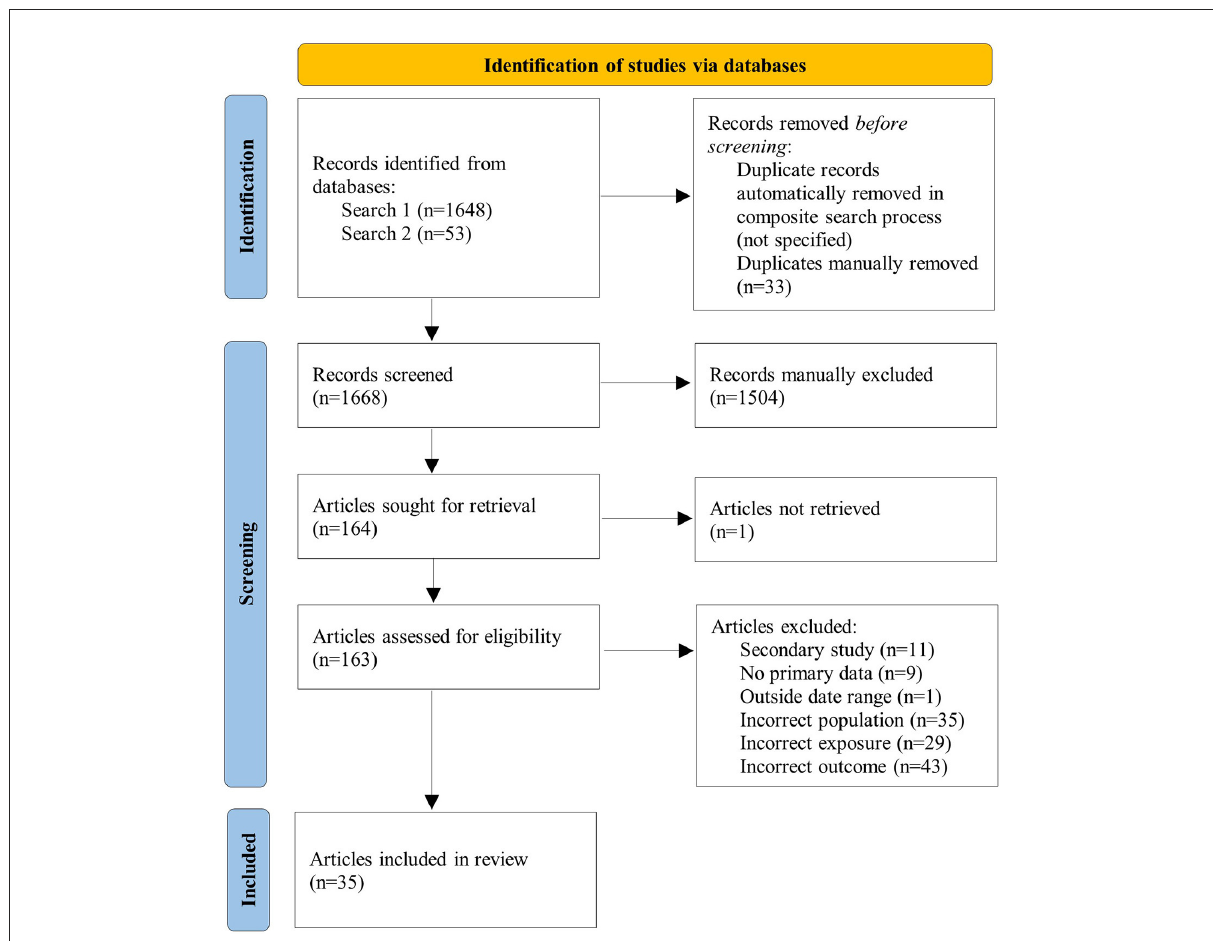
FIGURE1 PRISMA flowchart of data collection and screening [Adapted from Page et al.